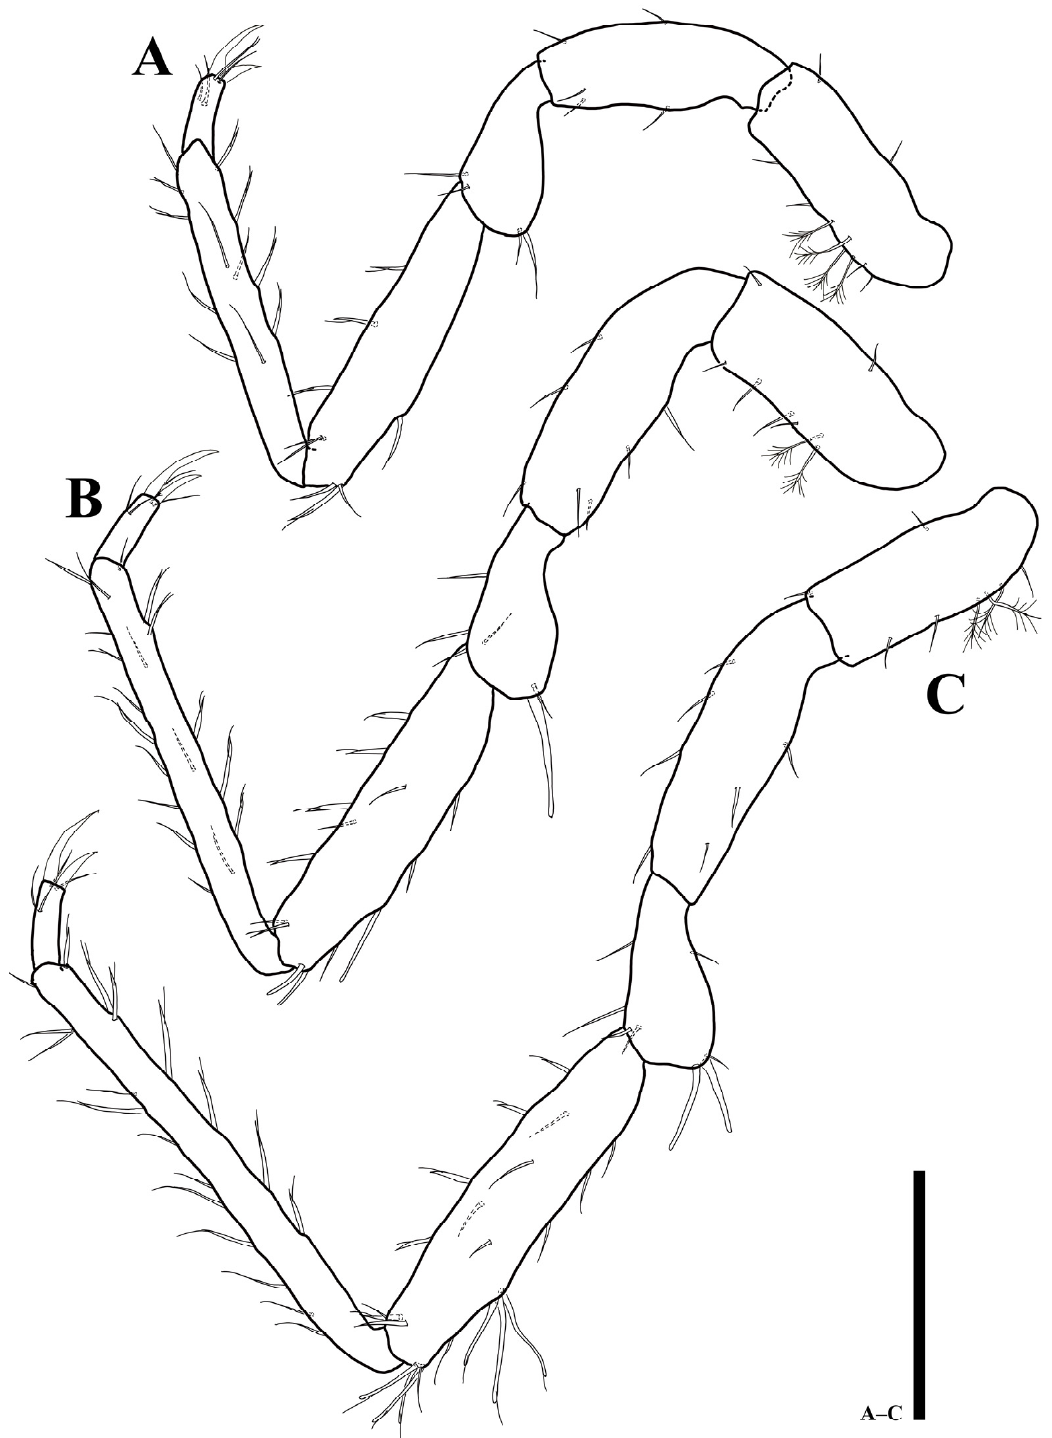
Figure 5. Uromunna mundongensis sp. n. holotype male: ( A ) pereopod 3; ( B ) pereopod 4; ( C ) pereo- pod 5. Scale bar = 100 μ m.